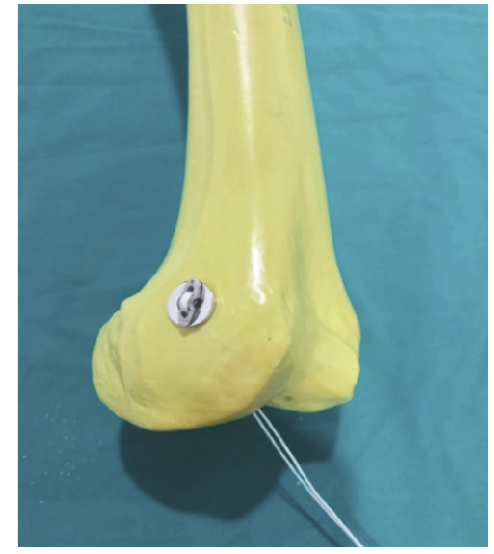
Image showing position of endobutton and washer on Fig. 3: femur.